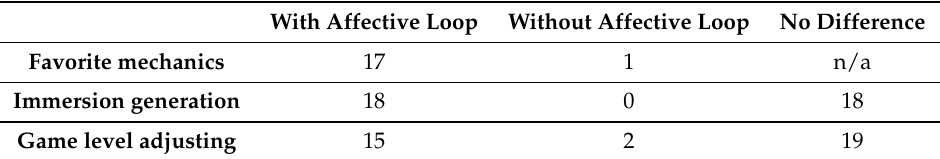
Table 1. Survey answers, according to separate dimensions